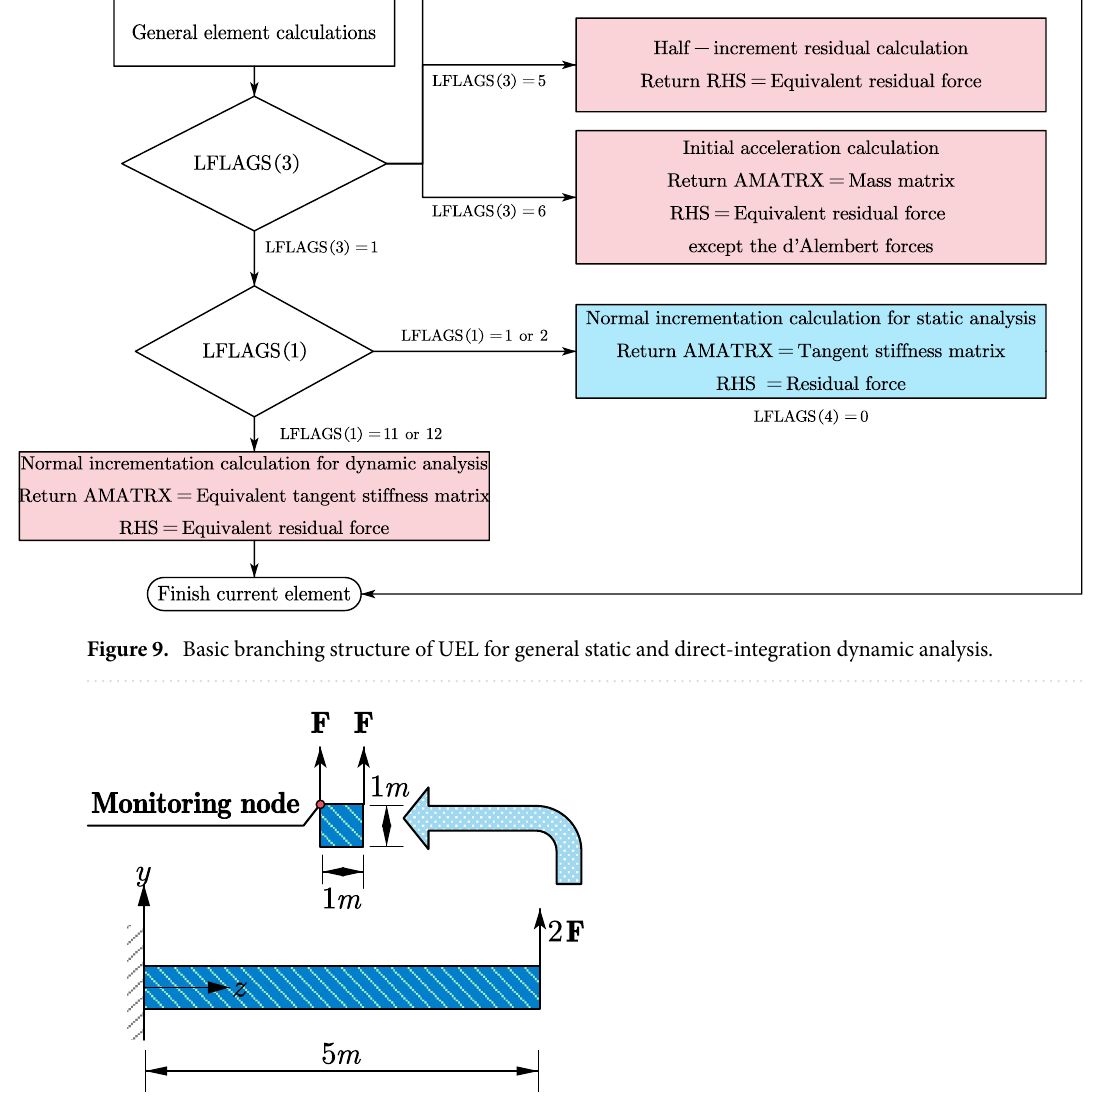
Figure 10. Geometry, load and boundary conditions of the